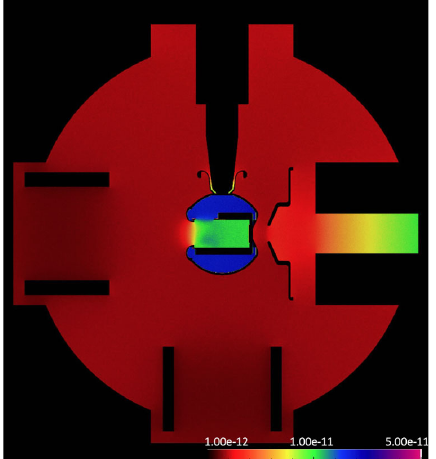
FIG. 8. The dynamic vacuum distribution in the gun